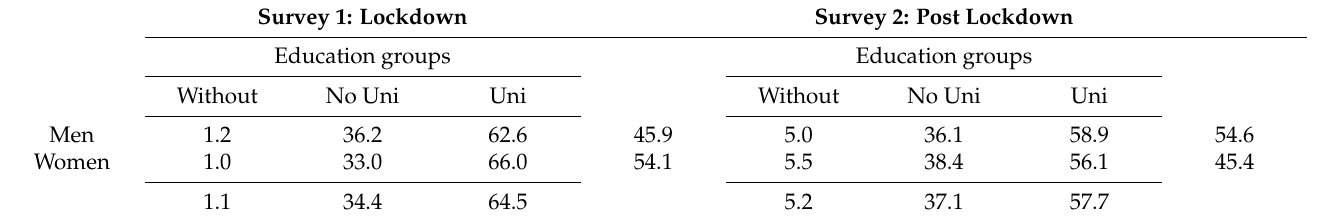
Table 2. Education-Gender distributions of the collected data (percentages).